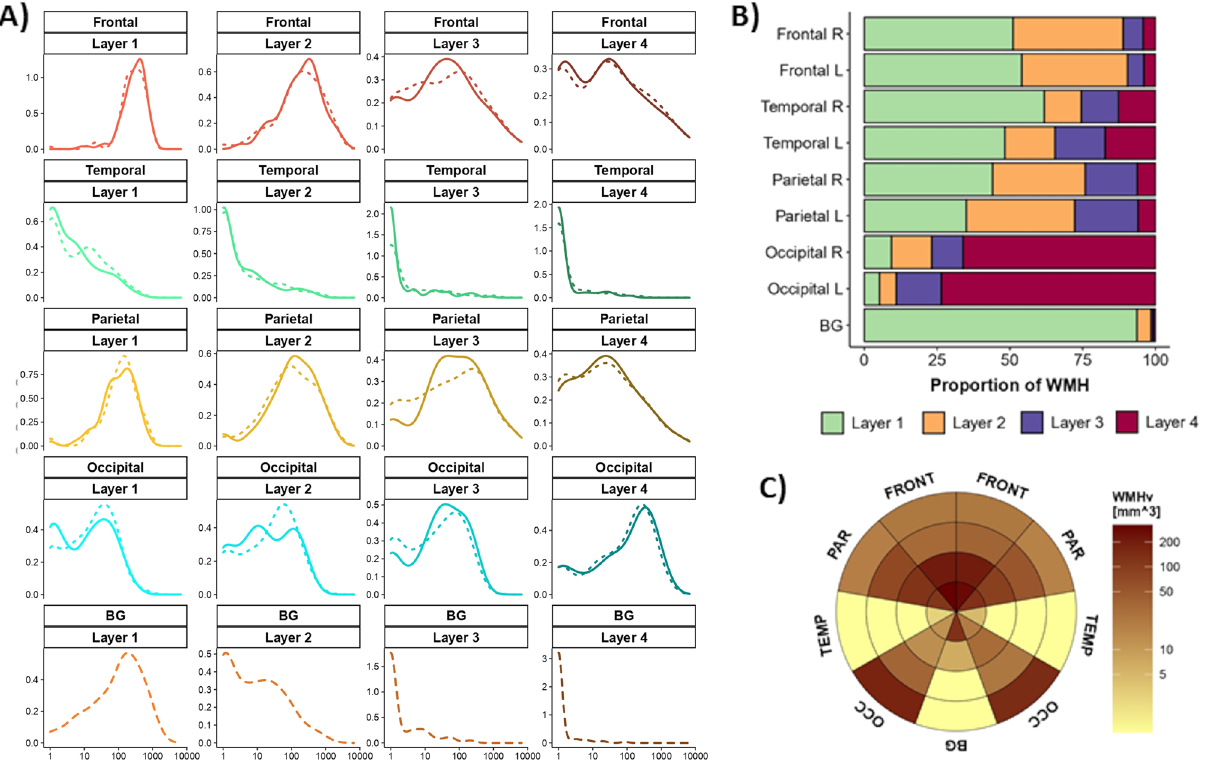
Figure 2. WMH distribution in the sample (N = 108). (A) Density plots of WMH in the sample. Y axis corresponds to the density function, while X axis corresponds to the WMH volume in mm 3 (and scaled to log10). Colors correspond to the lobar regions (frontal, temporal, parietal, occipital lobes, and basal ganglia) and line types to the hemisphere (solid lines: left hemisphere; short-dashed lines: right hemisphere; long- dashed lines: both hemispheres, only in basal ganglia). (B) Proportion of WMH per layer in each lobar region. Colors correspond to the layer number (1 to 4) according to the legend. (C) Median WMH in each parcel of the bullseye representation in the whole sample. Colors represent the burden of WMH in mm 3 . Darker colors indicate higher WMH loads. This figure was constructed using ‘ggplot’ library (version 3.3.2, https:// ggplo t2. tidyv erse. org/) included in R software (R version 3.6.3, 2020-02-29; 2020 The R Foundation for